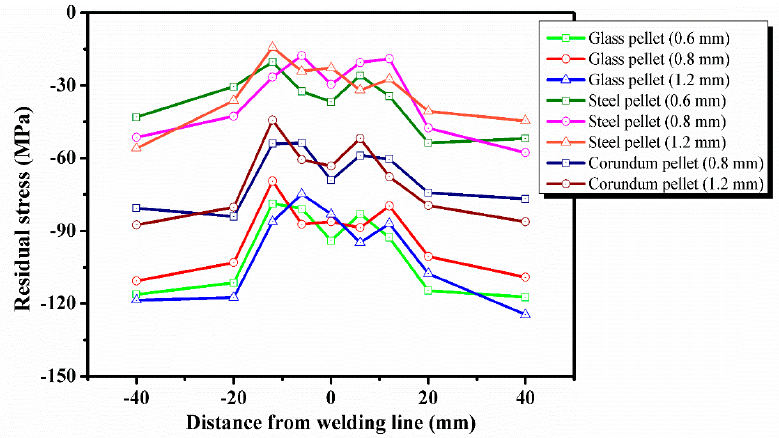
ff ect of shot peening on the redistribution of residual stress on the Figure 6. Effect of shot peening on the redistribution of residual stress on the surface. Figure 6. E